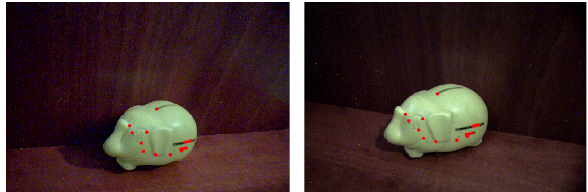
Figure 3: Matched points on the right image from the first scan position and the left image from the second scan position.